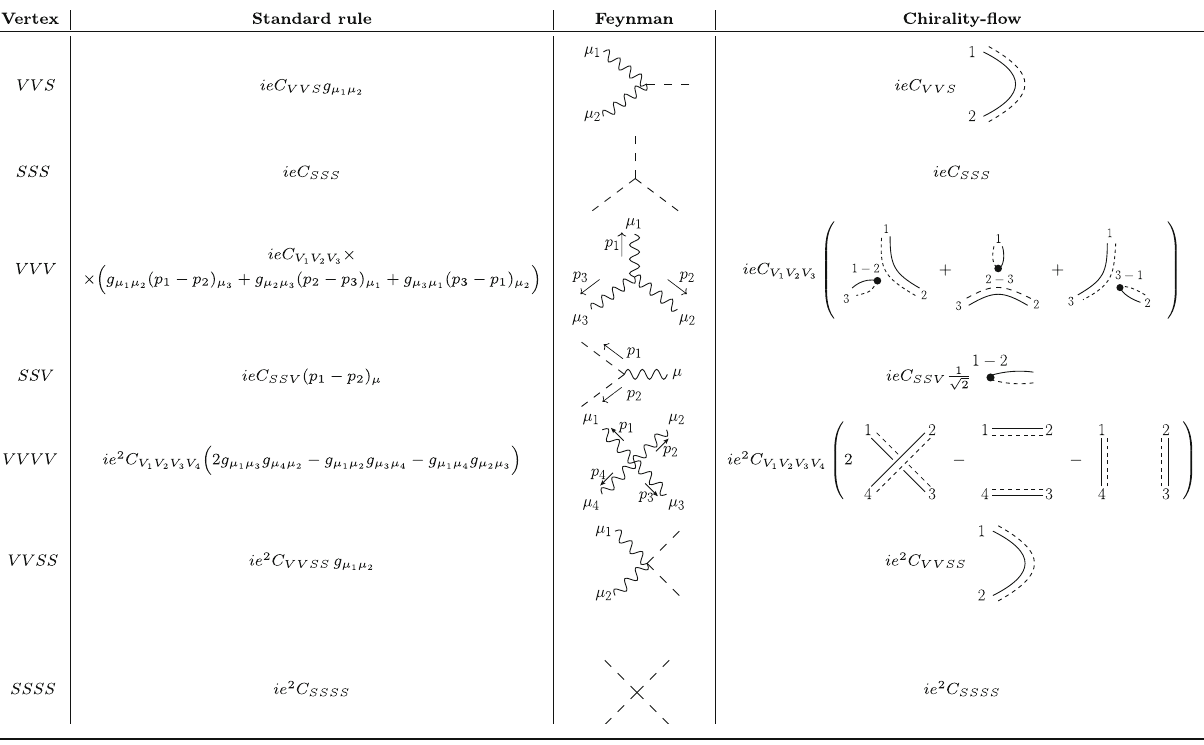
Table 5. The external spinors and polarization vectors are given in Tables 1 and 3